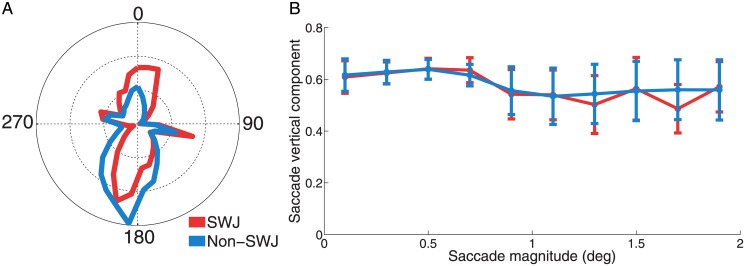
Direction of SWJ saccades and non-SWJ saccades.
A) Polar histogram of saccade directions for SWJ saccades and non-SWJ saccades. We show the average saccade direction distribution across monkeys (n = 5). Both SWJ saccades and non-SWJ saccades are biased vertically. Whereas downward-directed component is prominent for both SWJ saccades and non-SWJ saccades, the upward-directed component is more pronounced for SWJ saccades than non-SWJ saccades. Median Euclidean distance values were significantly lower for SWJ saccades than for non-SWJ saccades, indicating higher symmetry (Z-value = 2.02; p = 0.04; see Methods). B) Saccade magnitude and vertical component. The vertical component remained constant across saccadic magnitudes for both SWJ saccades (Friedman's test (5, 9) = 5.50; p = 0.787) and non-SWJ saccades (Friedman's test (5, 9) = 3.19; p = 0.956). Error bars represent the s.e.m. across monkeys (n = 5).